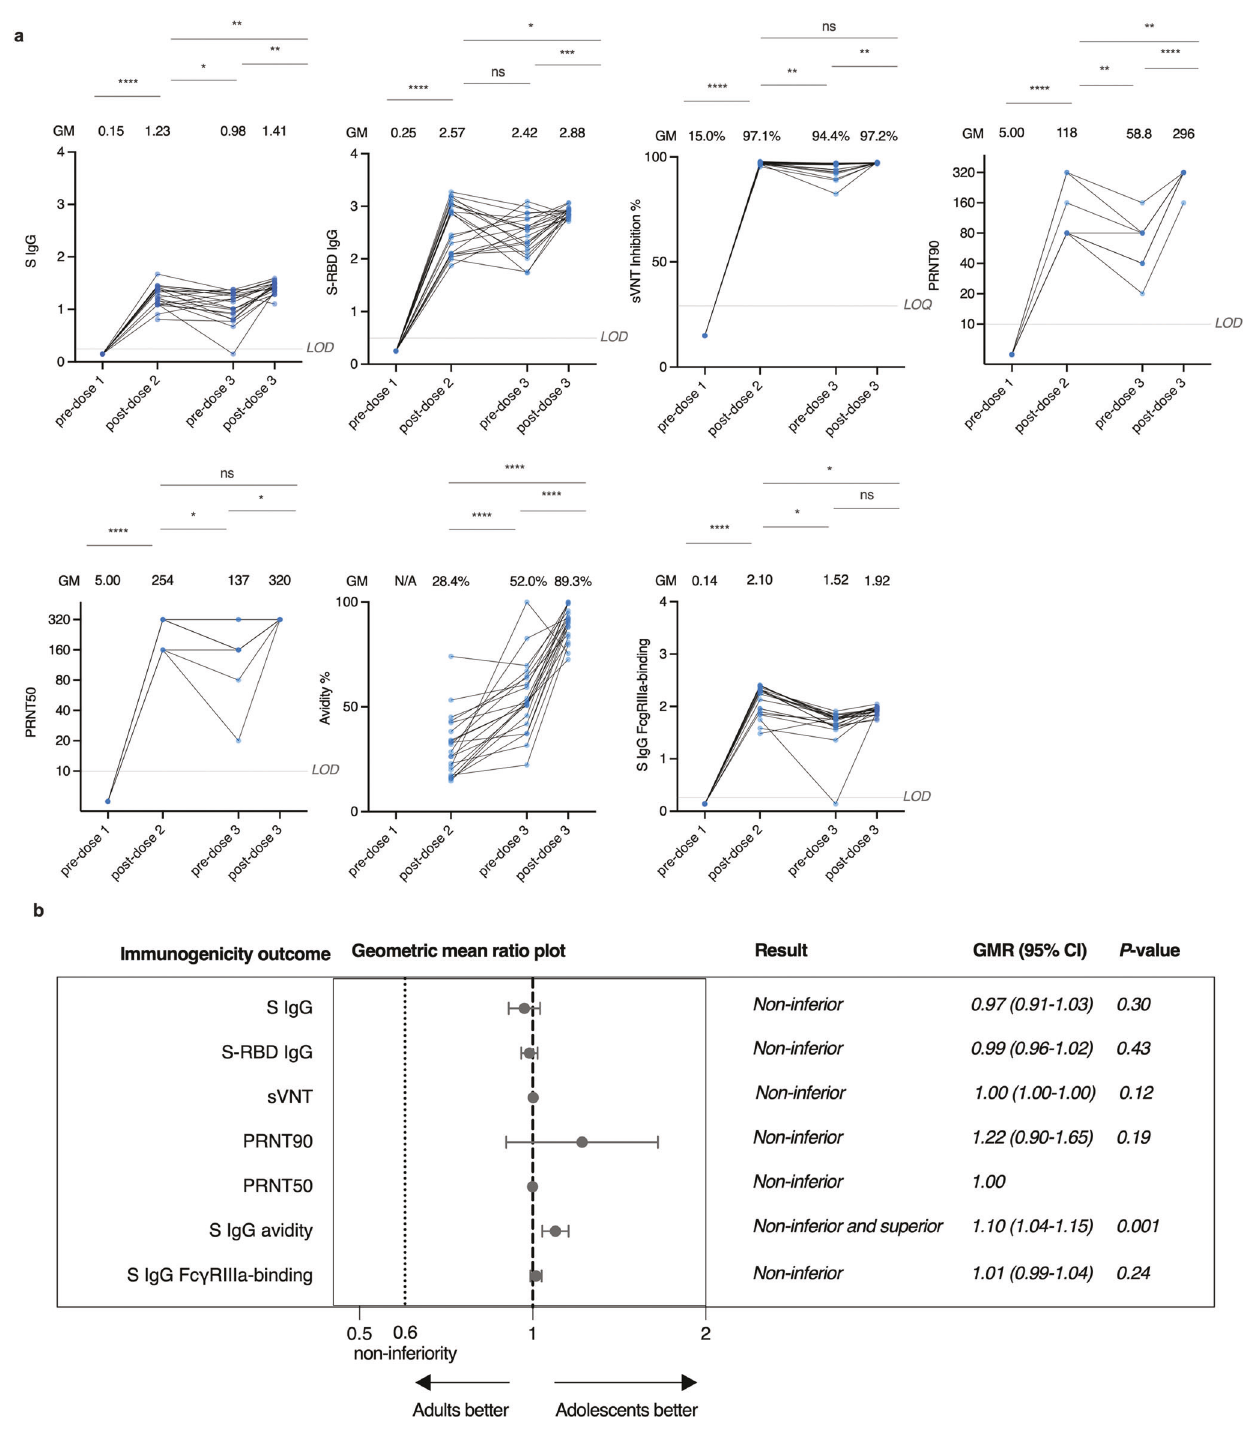
analysis population (Supplementary Table 3). We also found all adolescents tested had a positive T cell response with at least one cytokine and subset, while that of adults was signi fi cantly lower (85.7%, p = 0.011) (Table 2). We also calculated the geometric mean ratio for T cell responses in adolescents versus adults (Fig. 2b). Comparisons of S-speci fi c IFN- γ + and IL-2 + CD4 + T cell responses to adults were inconclusive as the 95% CI limits were wide and beyond the non-inferiority margin of 0.60 and 1 (Fig. 2b). However, S-speci fi c IFN- γ + (GMR 2.90, 95% CI 0.96 – 8.78) and IL-2 + (GMR 2.59, 95%